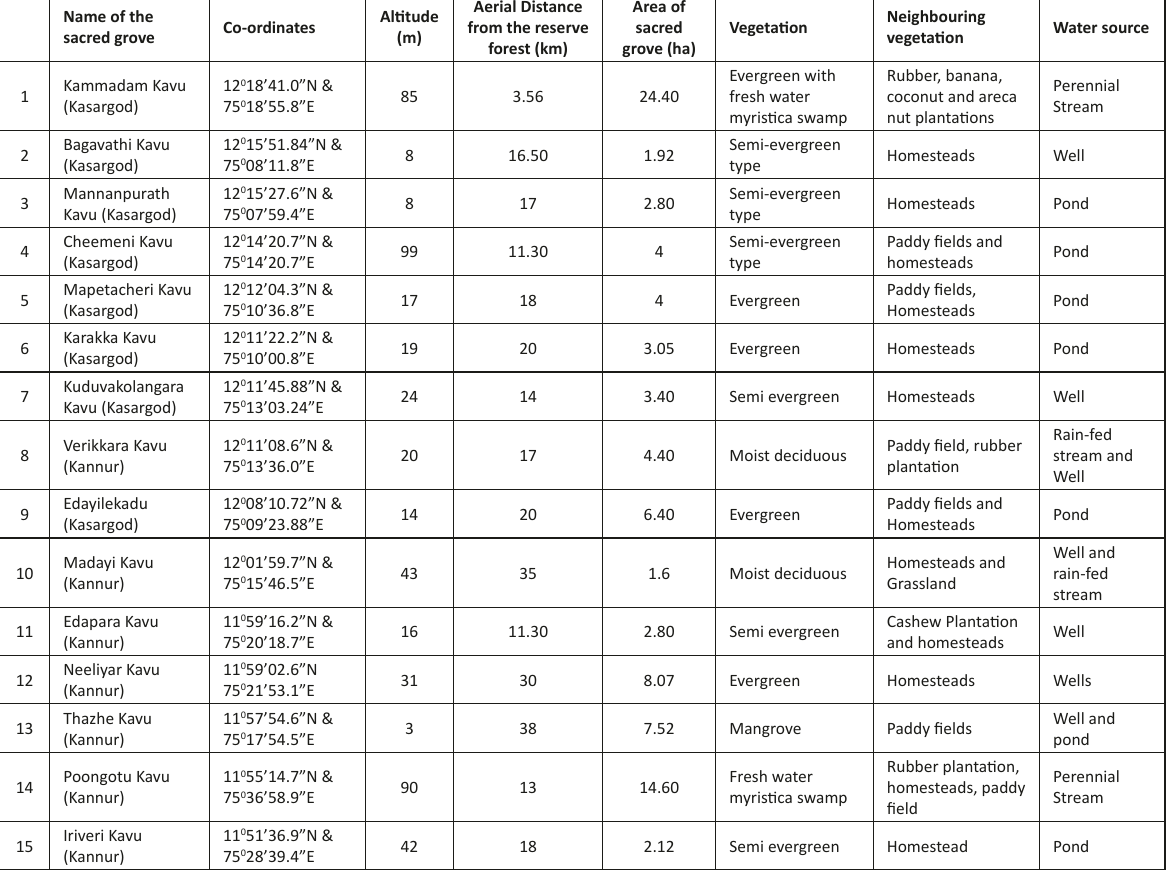
Table 1. Study locations selected in northern Kerala Name of the sacred